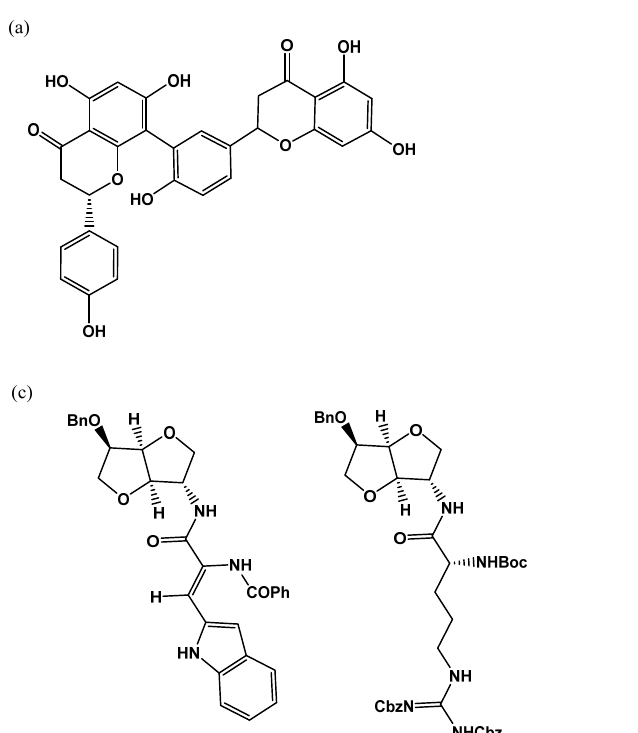
Figure 5. OGT inhibitors assessed by UDP-Glo assay: ( a ) L01 IC 50 = 22 μM; ( b ) Pep6 IC 50 = 385 μM, Pep13 IC 5O = 193, and bisubstrate inhibitor compound 6 IC 50 = 117 μM; ( c ) LQMED 269 IC 50 = 159 μM and LQMED 330 IC 50 = 11,7μM.